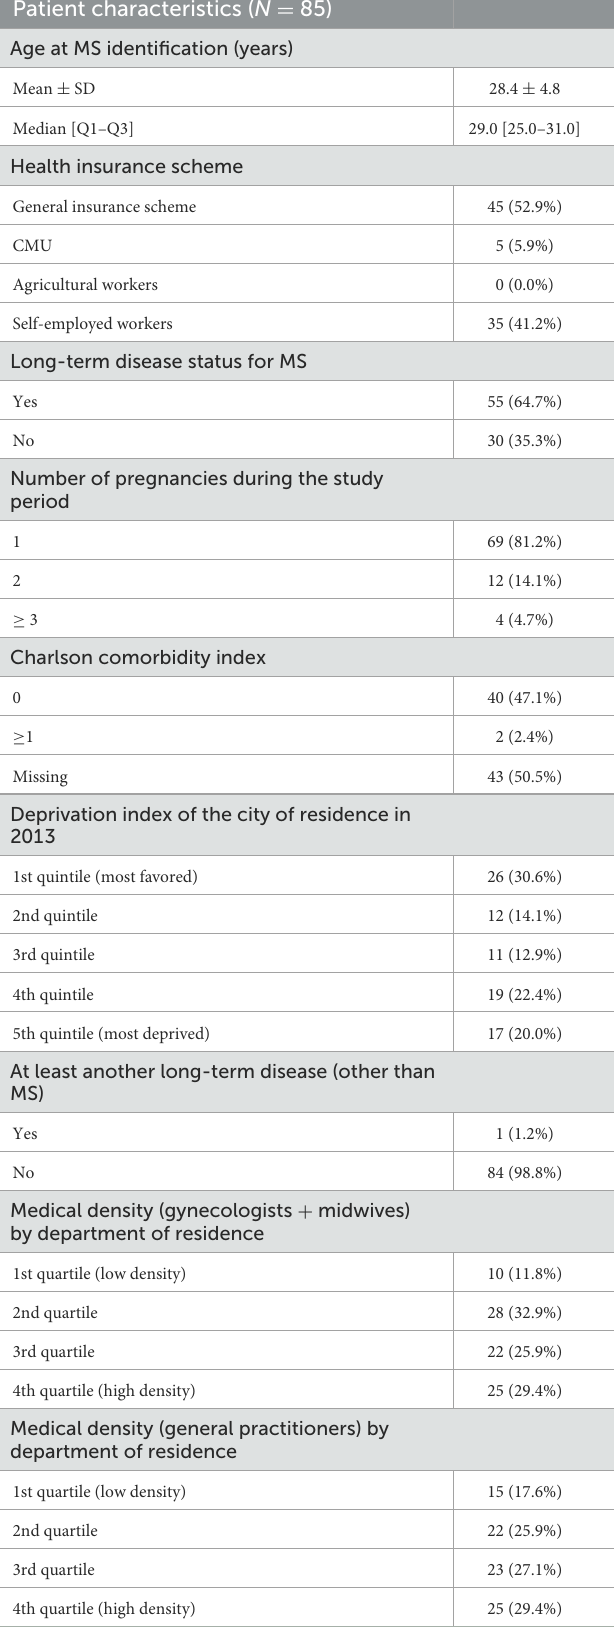
TABLE 3 Characteristics of women with MS without prenatal visits and laboratory tests ( N = 85). Patient characteristics ( N =